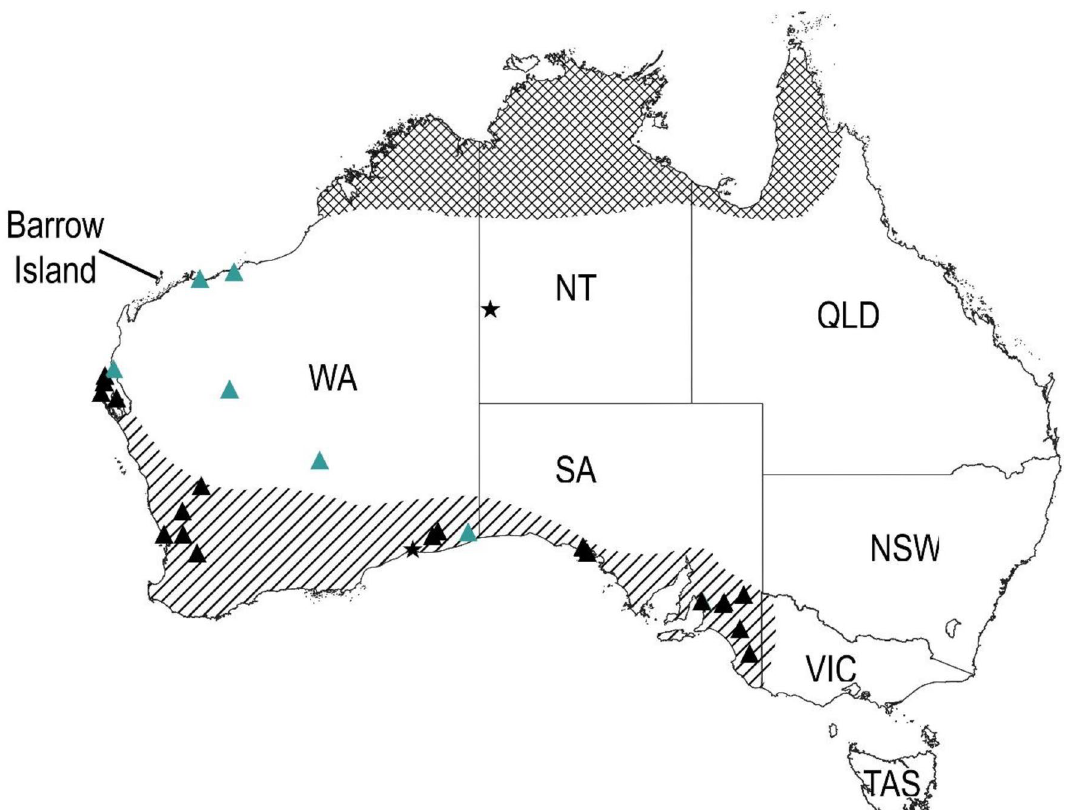
Figure 3. Current and historical distribution of banded hare-wallabies ( Lagostrophus fasciatus ), northern nail-tail wallabies ( Onychogalea unguifera ) and Bettongia anhydra . Black filled triangle: modern and subfossil occurrences of banded hare-wallabies; Green filled triangle: late nineteenth century sightings of banded hare-wallaby 38,66 ; Filled star: modern and subfossil occurrences of B. anhydra 67 . Diagonal hatching shows the historically understood range of banded hare-wallabies and cross hatching shows the current range of northern nail-tail wallabies 68 . Figure generated with QGIS (v.3.22) (www. qgis.